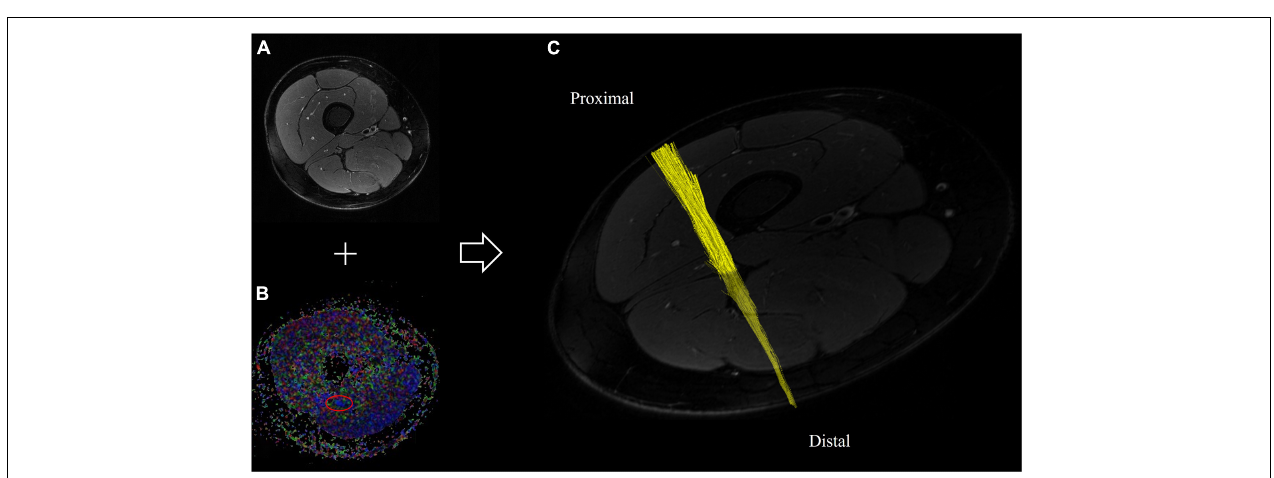
FIGURE 2 | Automated segmentation of the sciatic nerve based on diffusion-weighted and T2-weighted imaging. (A) T2-weighted cross-sectional image of the right thigh, and (B) corresponding fractional anisotropy map. The sciatic nerve is delineated in red. (C) Reconstructed fiber tracts of the sciatic nerve based on diffusion-tensor imaging of the proximal